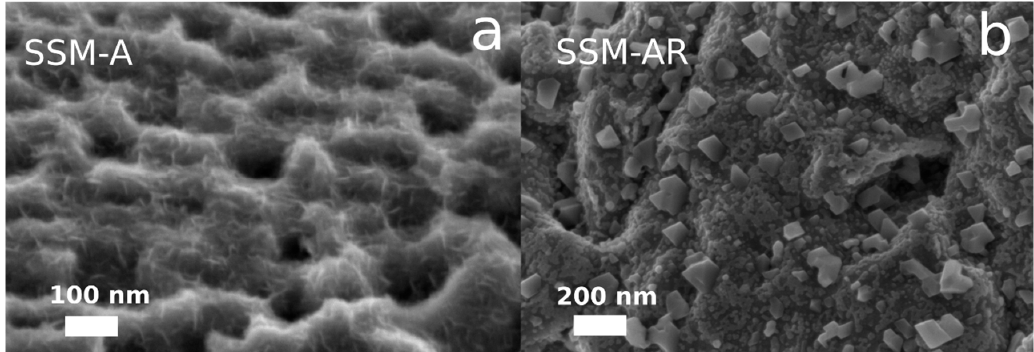
Figure 2. SEM micrographs of ( a ) the anodized SSM (SSM-A) displaying Ni-Fe nanosheets, and ( b ) the reduced SSM (SSM-AR) where the nanosheets agglomerate into nanoparticles. Note the di ff erent scalebars.